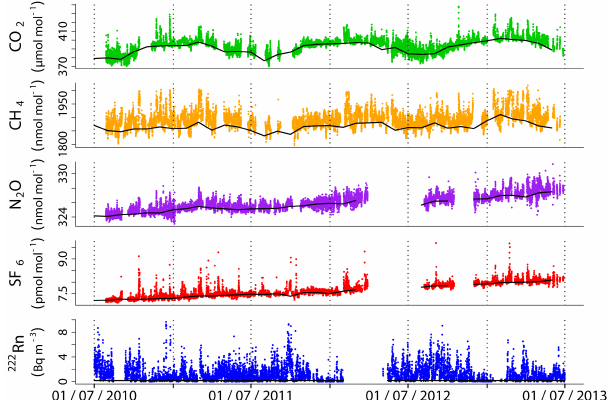
Figure 5. Hourly mole fractions of CO 2 , CH 4 , N 2 O and SF 6 at- mospheric ambient air and hourly activities of 222 Rn at Puy de Dôme from July 2010 to June 2013. The black lines are the respec- tive monthly GHG background mole fractions of the Puy de Dôme measurements (between 22:00 and 06:00UTC) and the 222 Rn back- ground activity at Mace Head